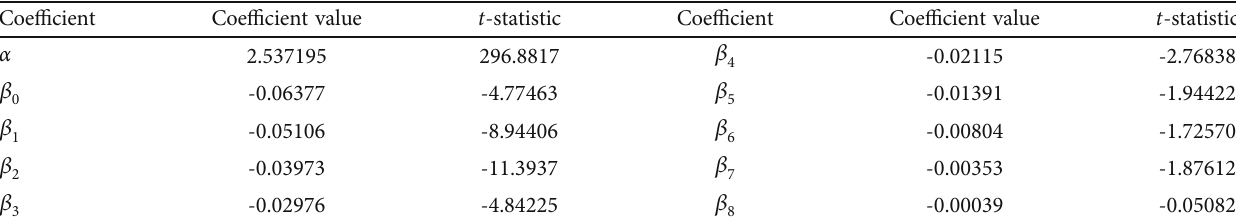
Table 2: Regression results of the distributed lag model without distal